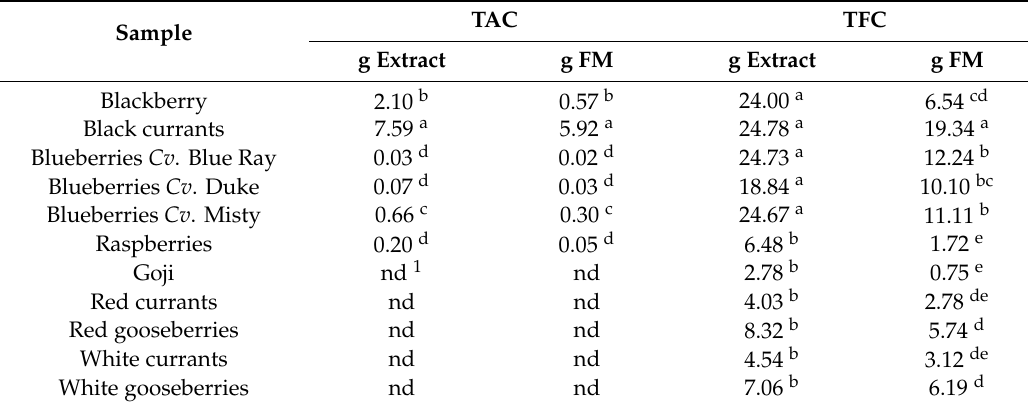
Table 2. Total anthocyanins (TAC; mg cia-3-glu eq. / g) and total flavonoids (TFC; mg rutin eq. / g) of the berry extracts and fresh material